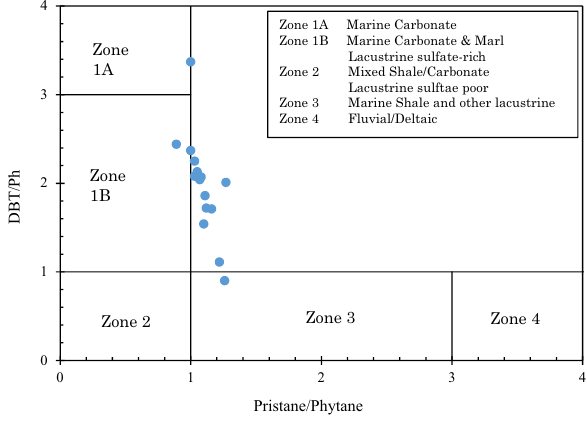
Fig. 7 Pristane/phytane versus dibezothiophene/phenanthrene for the South Dezful Embayment oils, indicating a marine carbonate/marl source rock with relatively high sulfur content (after Hughes et al.